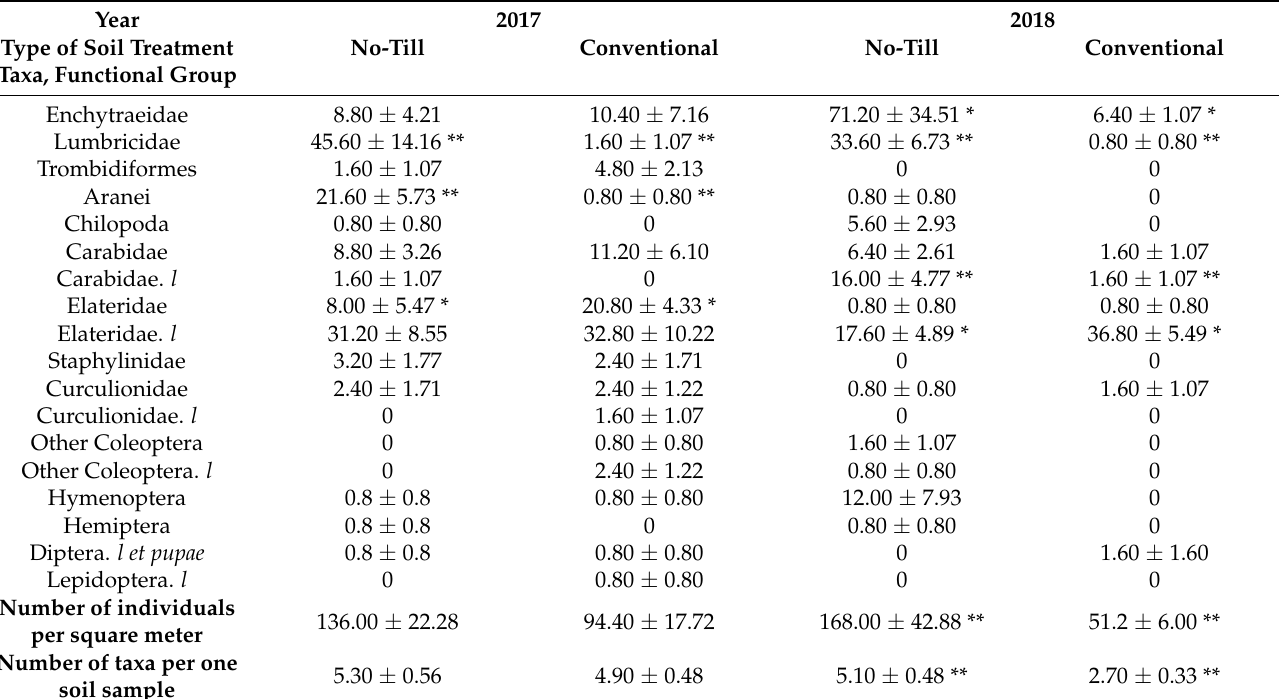
Table 3. Mean numbers and standard errors for specimens and taxa of soil invertebrates of the main systematic and functional groups per one square meter (for the number of taxa, per soil sample) depending on the type of tillage (conventional or